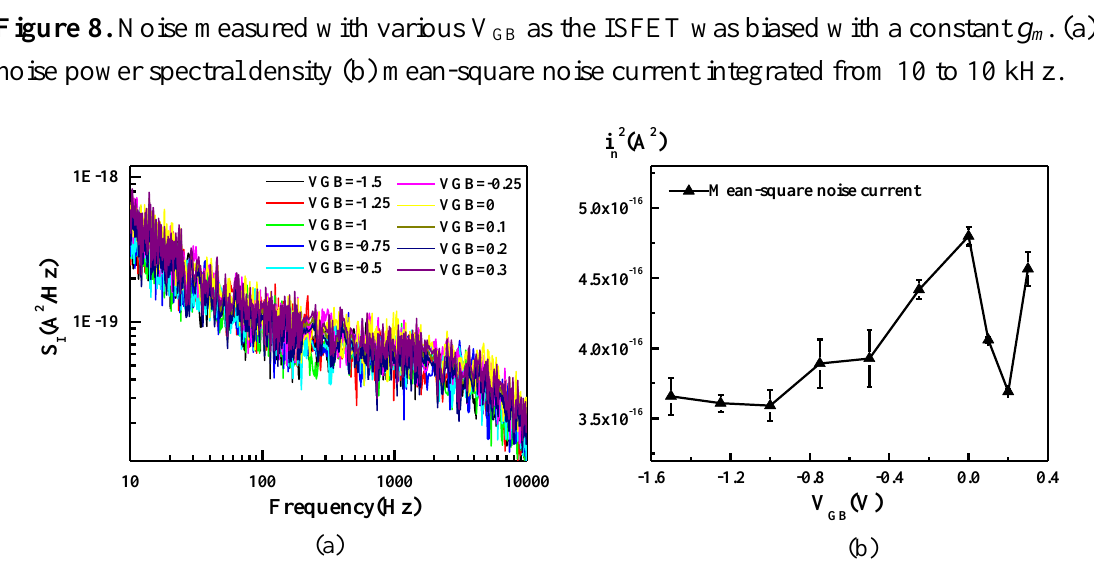
as the ISFET was biased with a constant g GB